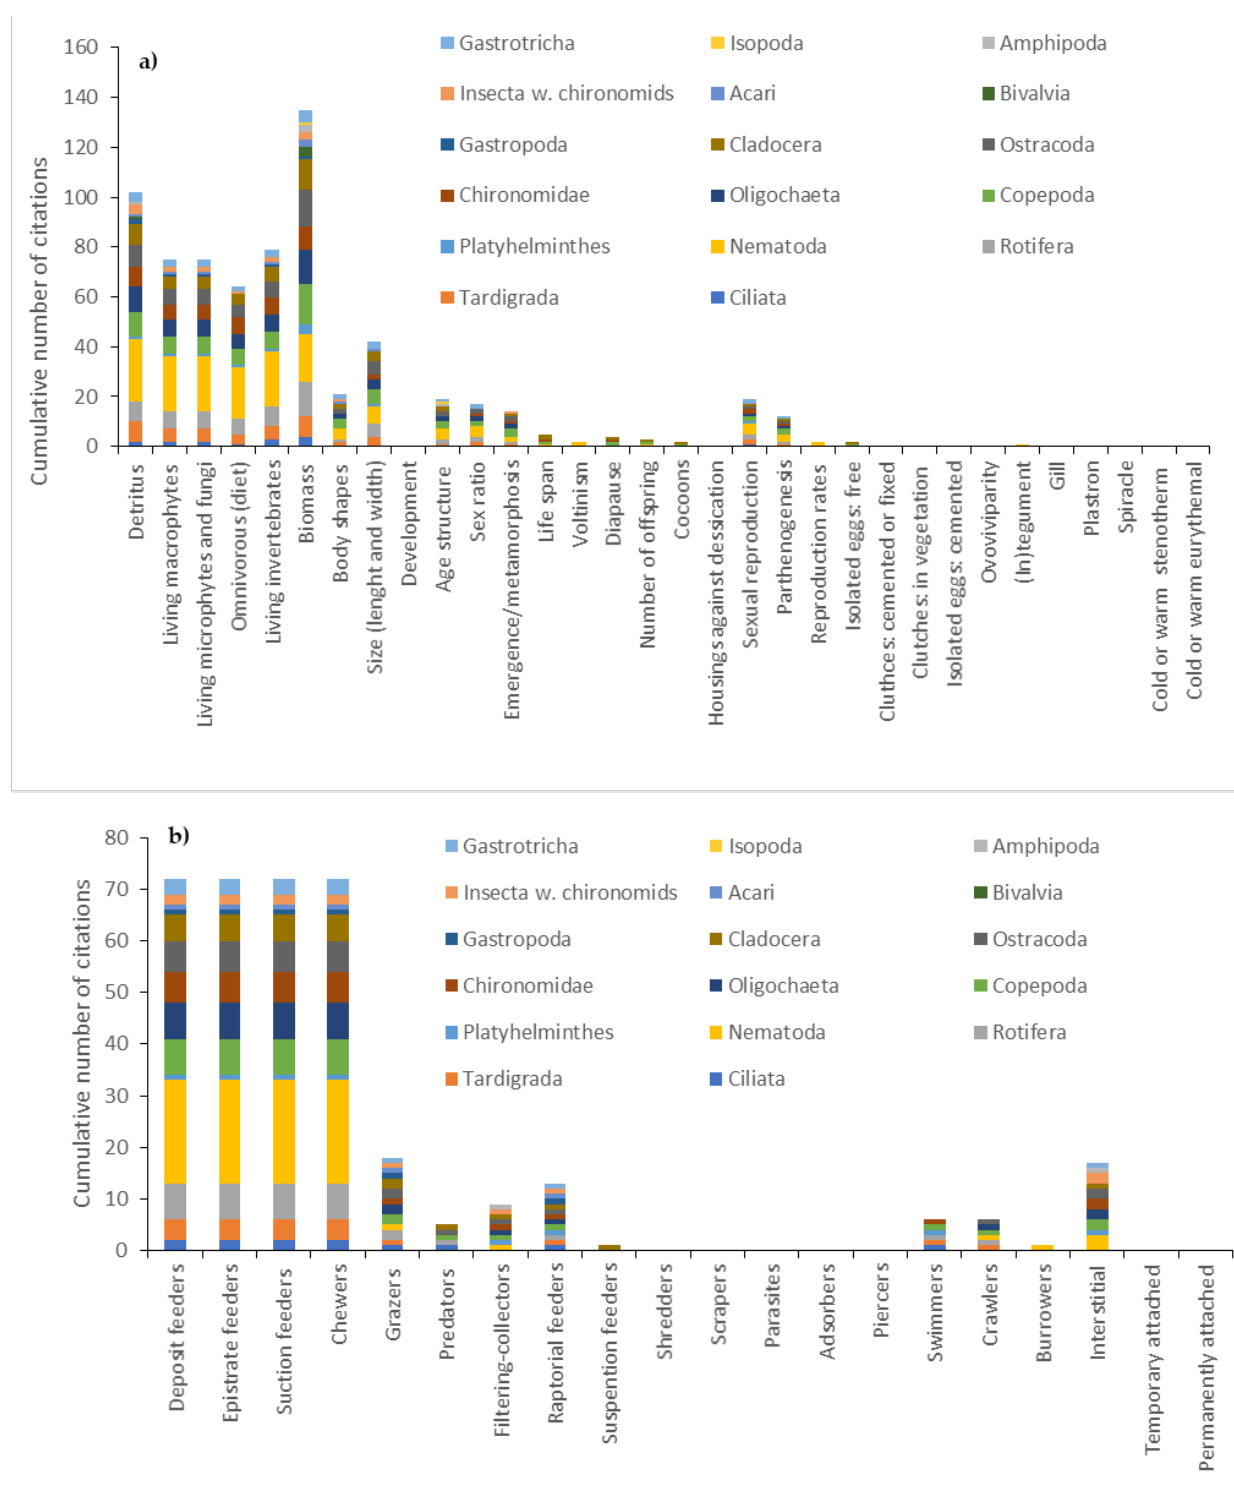
Figure 4. Cumulative number of citations of the 52 keywords associated with different meiofaunal taxa and related to ( a ) effect and ( b ) response traits. w.: without.